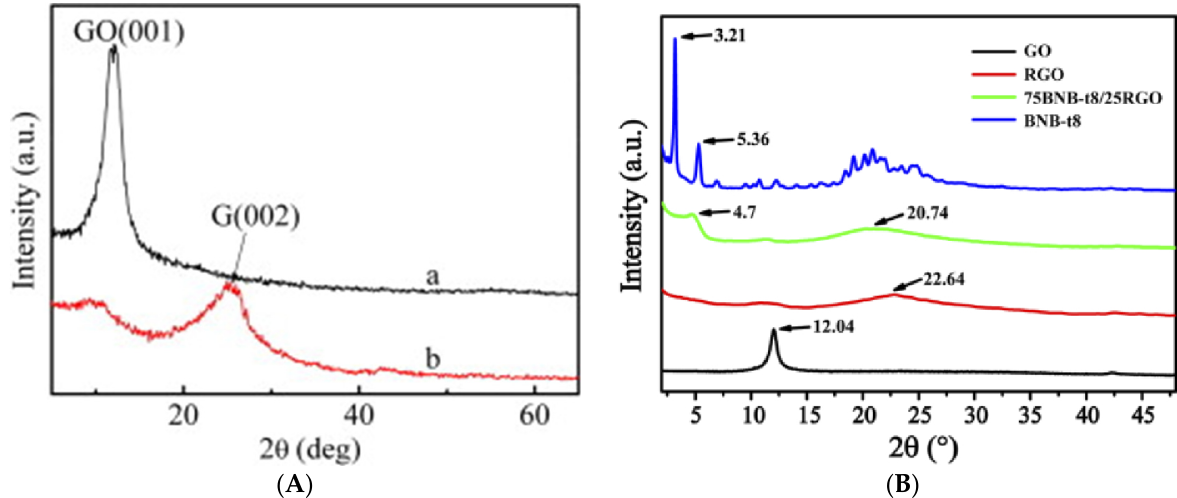
Figure 19. XRD patterns of GD-AZO hybrids via ( A ) Covalent (a) GO, (b) GO-AZO. (Reprinted from [97]; Copyright @ 2010 Elsevier) Additionally, ( B ) Non-covalent linkage [111].